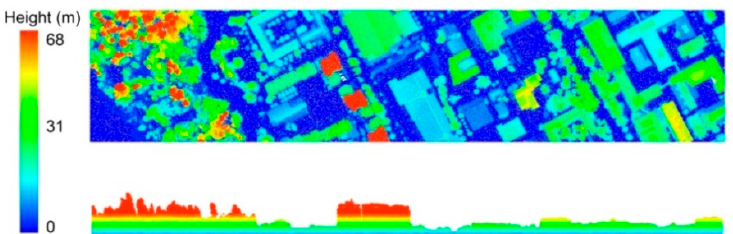
Figure 2. Section of light detection and ranging (LiDAR) data colored by height on the Vancouver UBC main campus (generated in LiDAR360 v4.0 by GreenValley International).